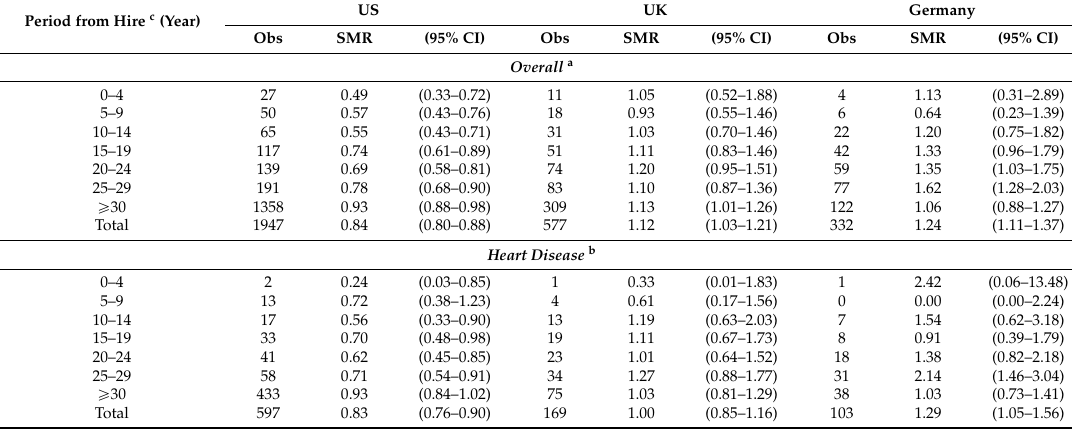
Table 1. Observed (Obs) deaths, standardised mortality ratios (SMRs), and 95% confidence intervals (CI) for overall a and cardiac b mortality based on national rates by period from hire, in carbon black production workers (full cohorts).